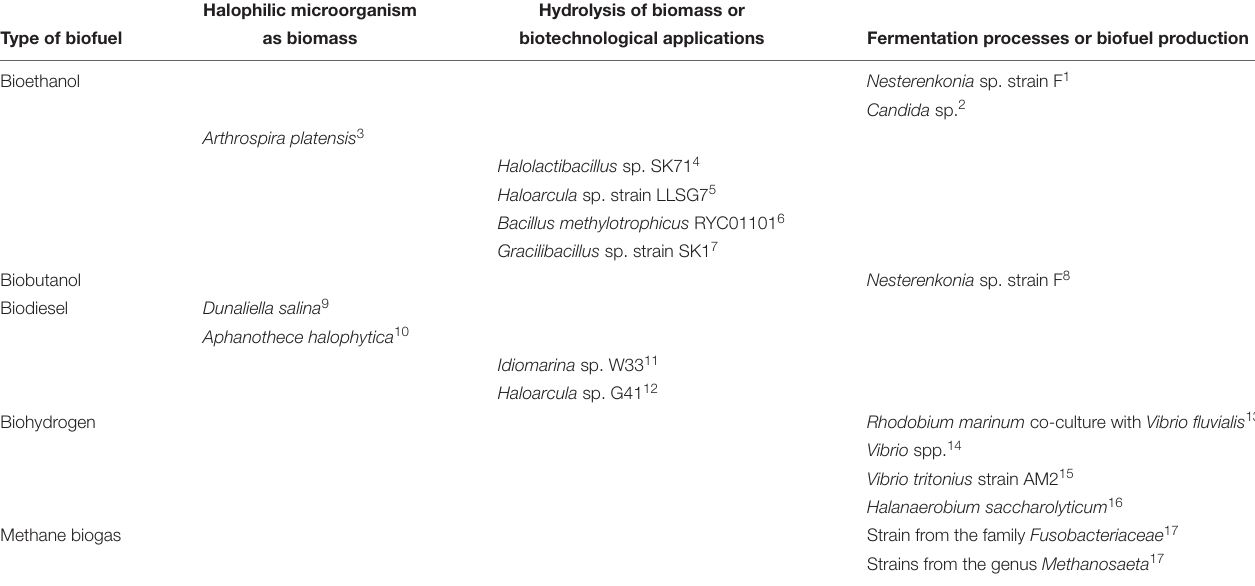
TABLE 4 | Current halophilic microorganism used in biofuel